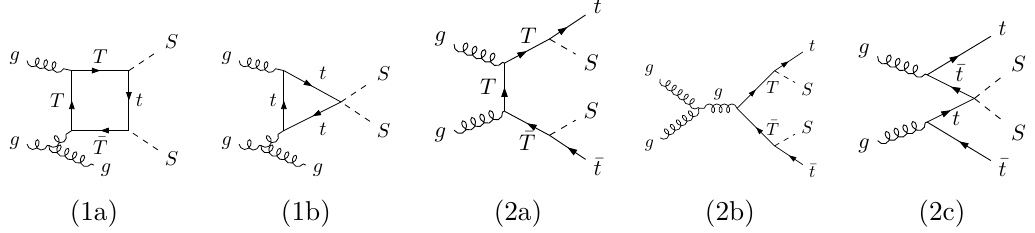
Figure 7 . Processes contributing to the collider signatures of our top-philic DM model. Diagrams (1a) and (1b) yield a mono-jet signature (or a multi-jet plus missing energy one after accounting for initial-state radiation) while diagrams (2a-c) contribute to the t ¯ tSS final state. Only diagrams (1b) and (2c) depend on the dimension-five